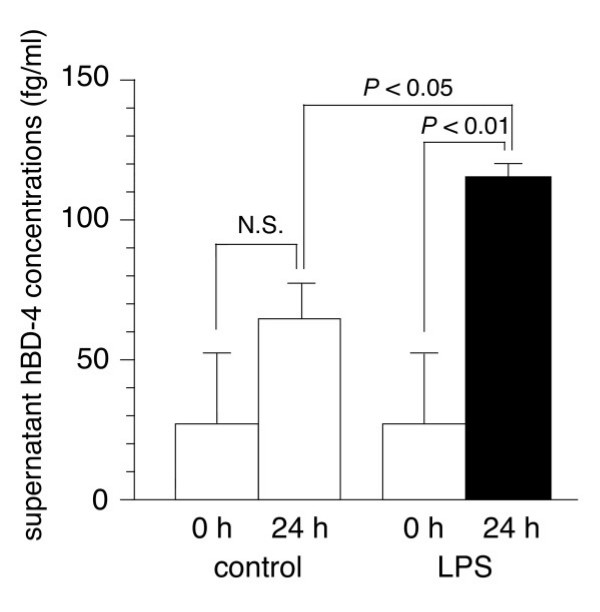
Expression profiles of hBD-4 SAECs. hBD-4 peptide concentrations in supernatants of SAECs after 24 h incubation with medium alone (control; open bars), and 100 μg/ml of LPS (solid bar). Values represent the means ± SD of three experiments. (SAECs: small airway epithelial cells, LPS: lipopolysaccharide)